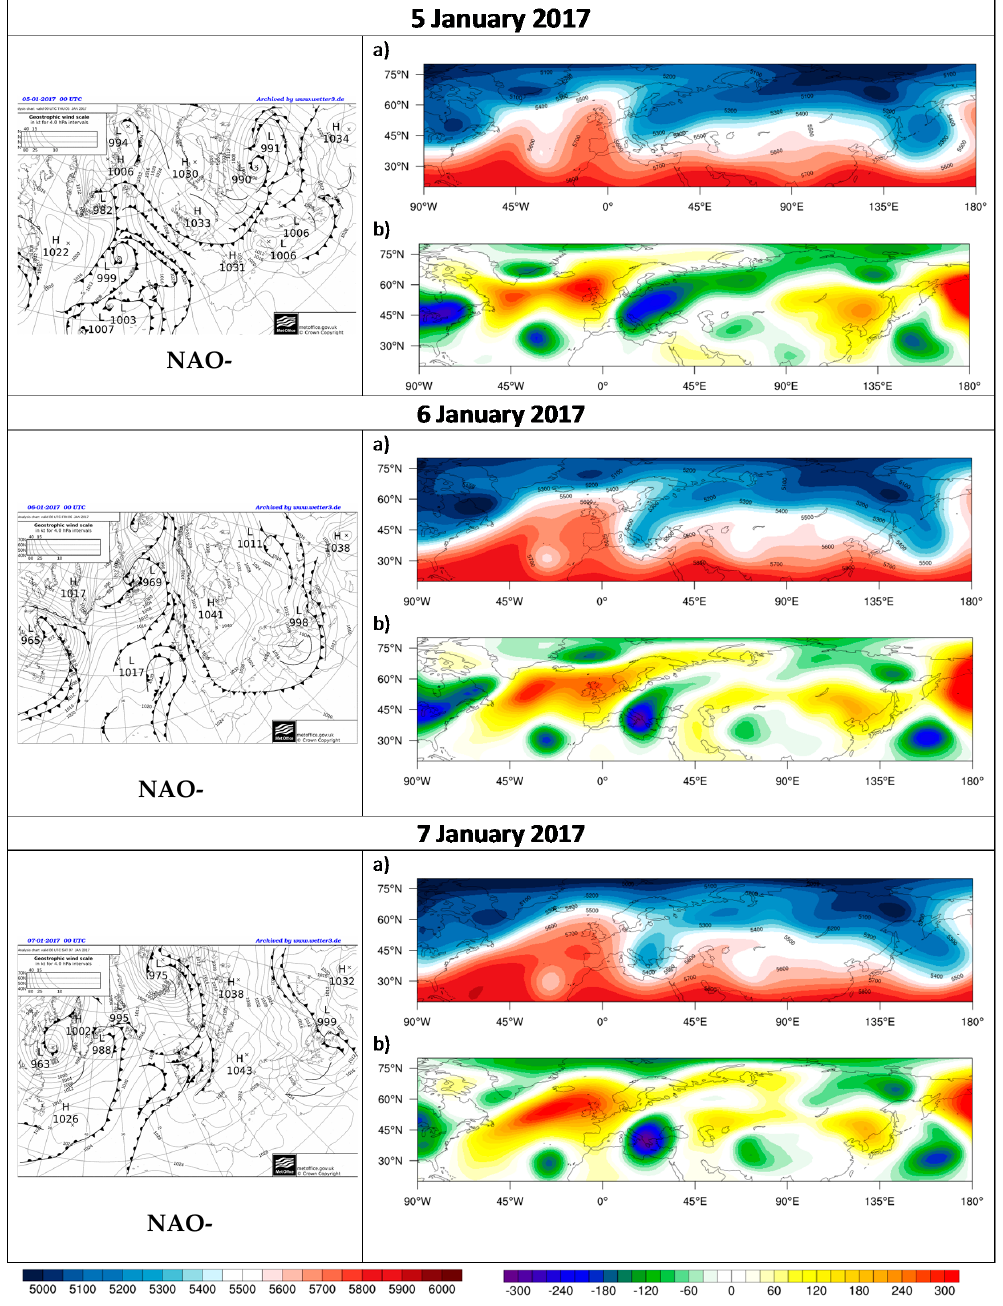
Figure 5. The synoptic pattern for the P-1 stage (5–7 January 2017) and the temporal variation of the NAO. First column: SLP (Met Office; www.wetter3.de); second column: ( a ) geopotential height of 500 hPa and ( b ) anomalies of geopotential heights at 500 hPa level.